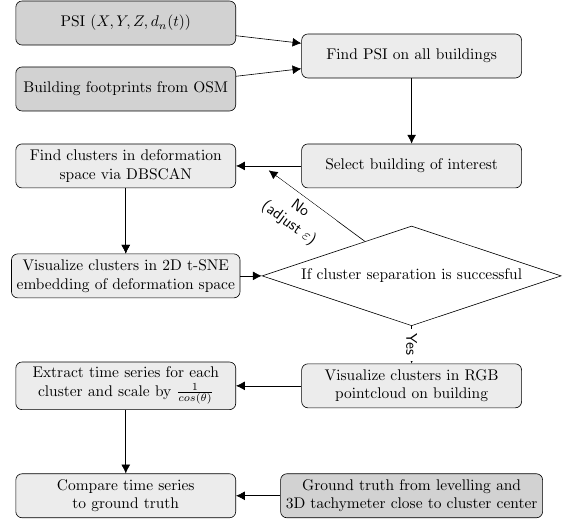
Figure 3. Workflow of our approach. Dark grey: Input data, light grey: Processing step. The decision loop allows to change the clustering parameters if the DBSCAN and t-SNE results deviate too much.